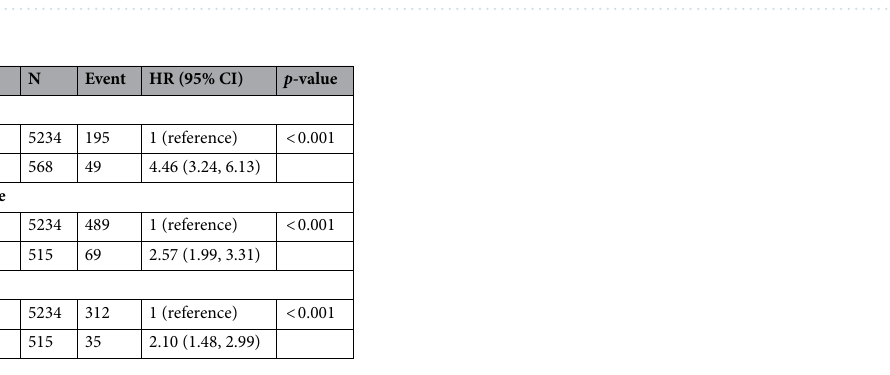
Table 6. Risk of death, graft failure and death-censored graft failure according to the presence of depression in KT group. KT kidney transplantation, DCGF death-censored graft